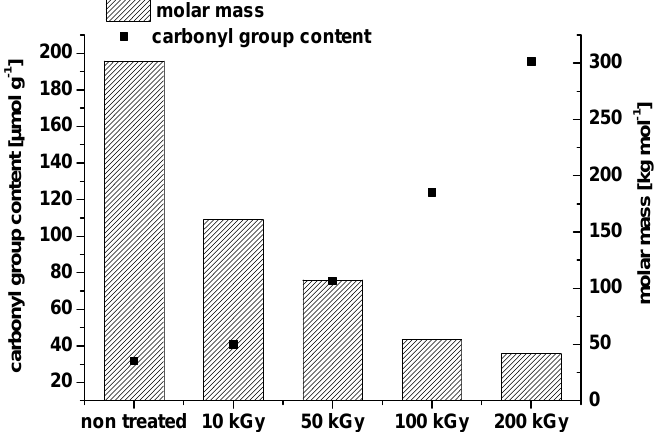
Figure 7. Freeze-dried nanofibrillated cellulose after electron beam irradiation of different